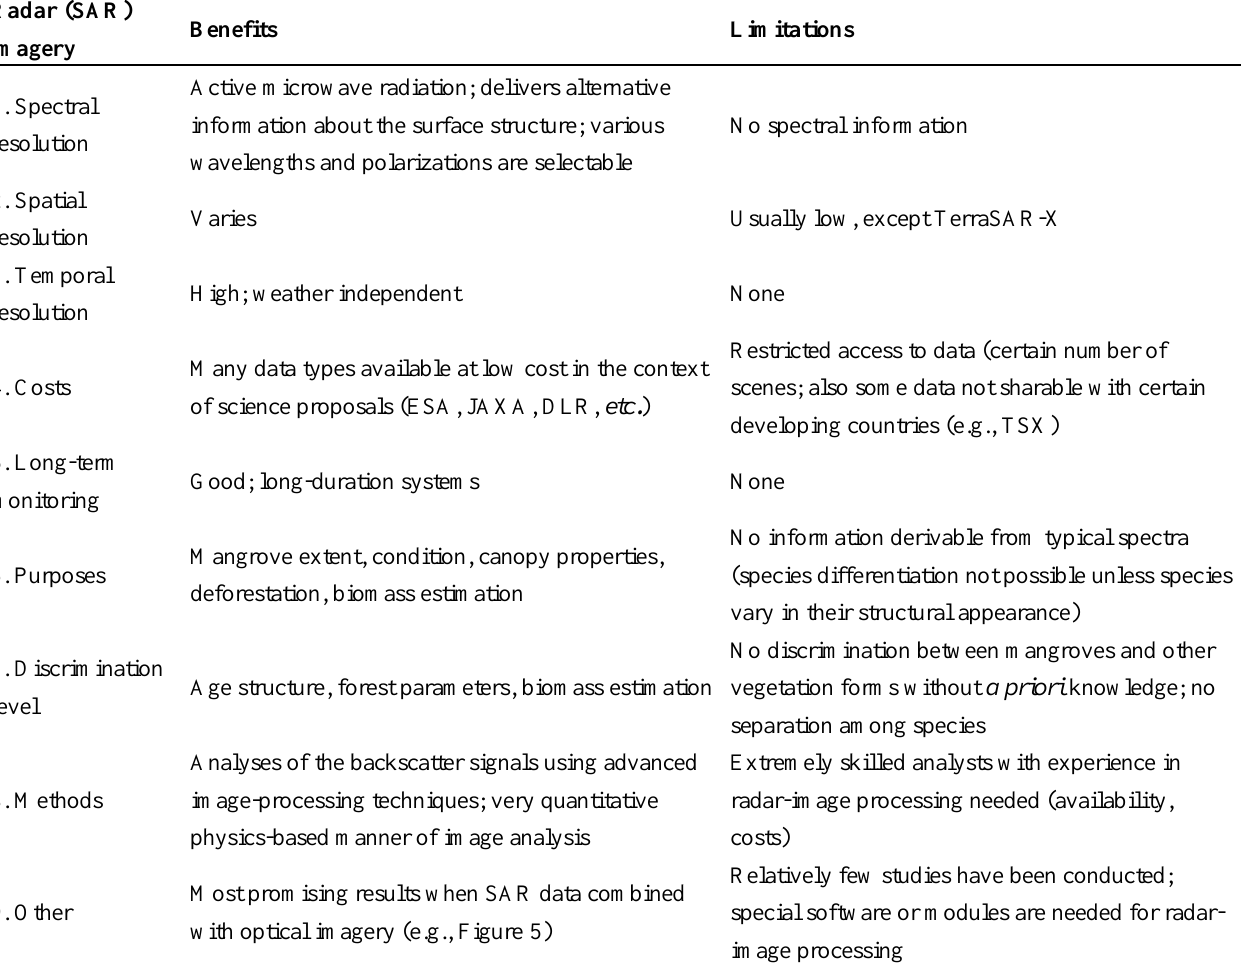
Table 7. Benefits and limitations of radar imagery for mangrove